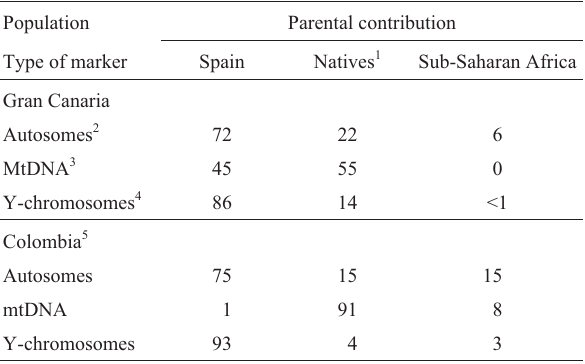
Table 3 - Parental contribution in Gran Canarian and Colombian popula- tions based on autosomal, Y-chromosome and mtDNA data